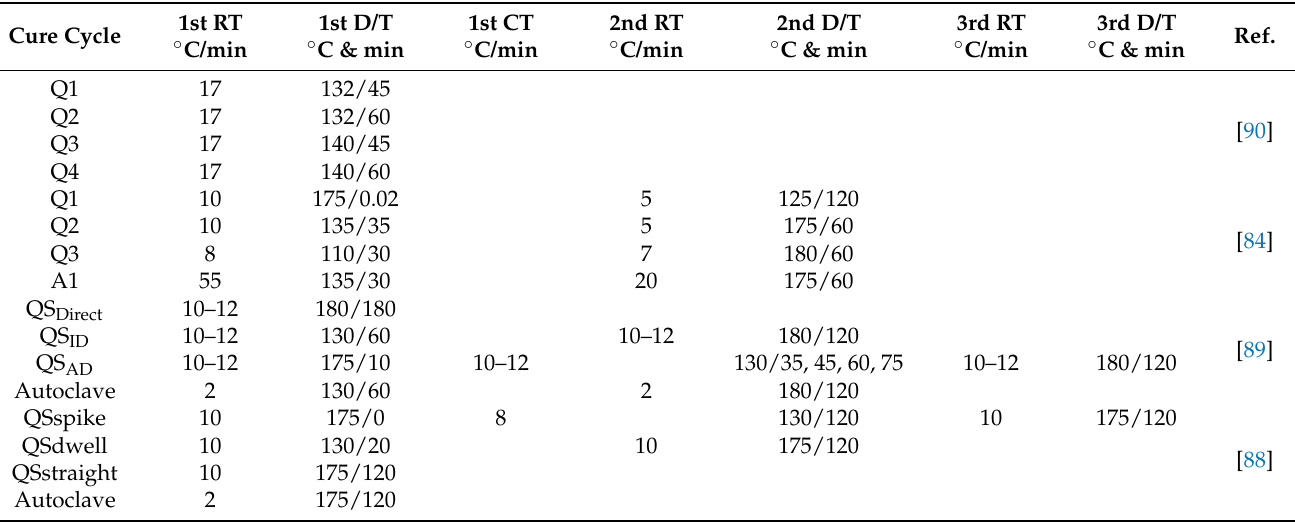
Table 3. Quickstep Different Curing